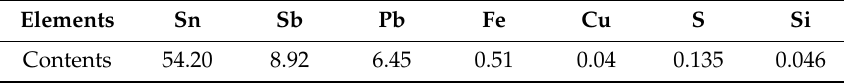
Table 1. Main chemical composition of lead refining dross (wt